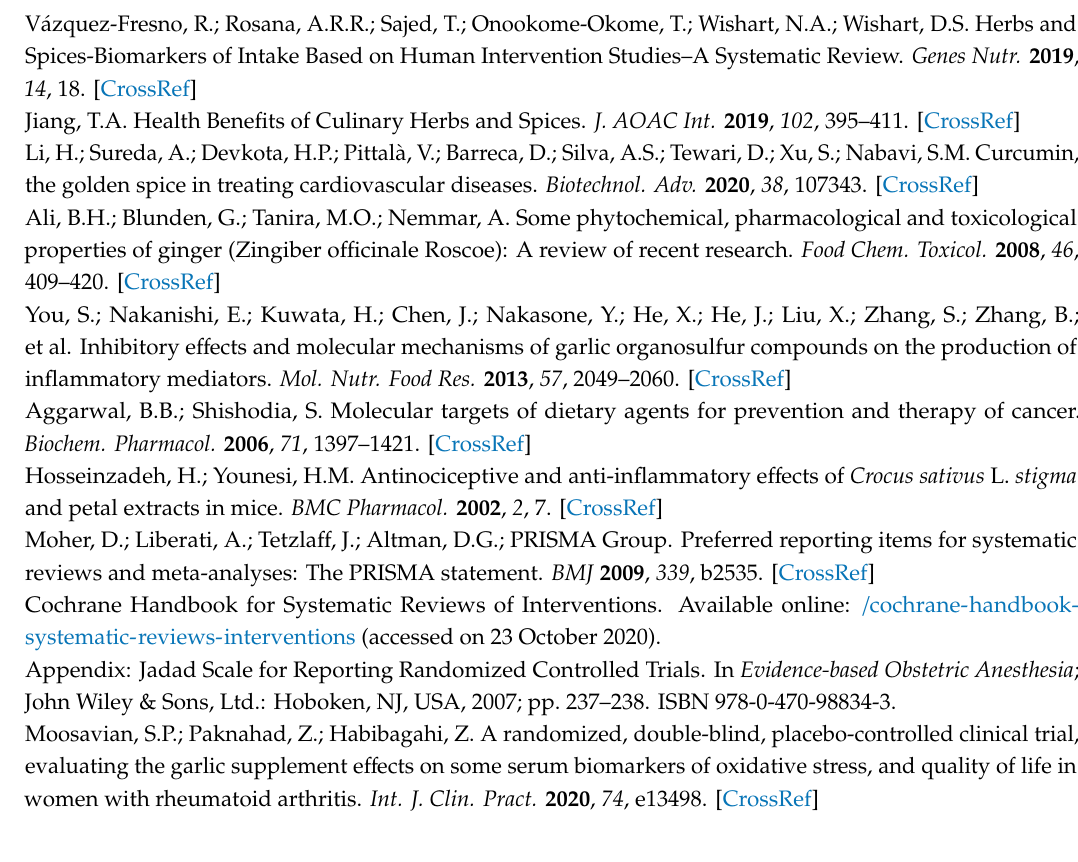
Table S1: Quality assessment based on Jadad score of randomized controlled trials